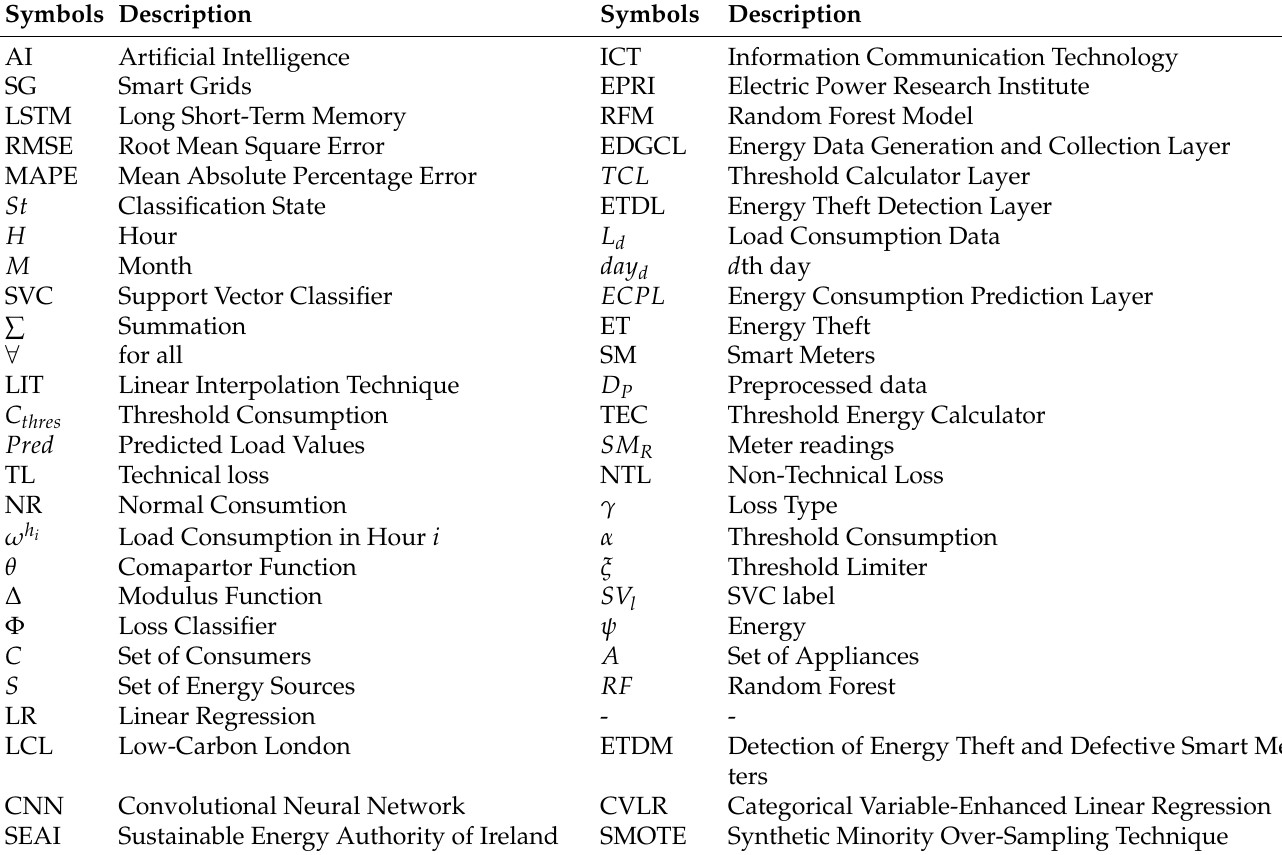
Table 1. Abbreviations